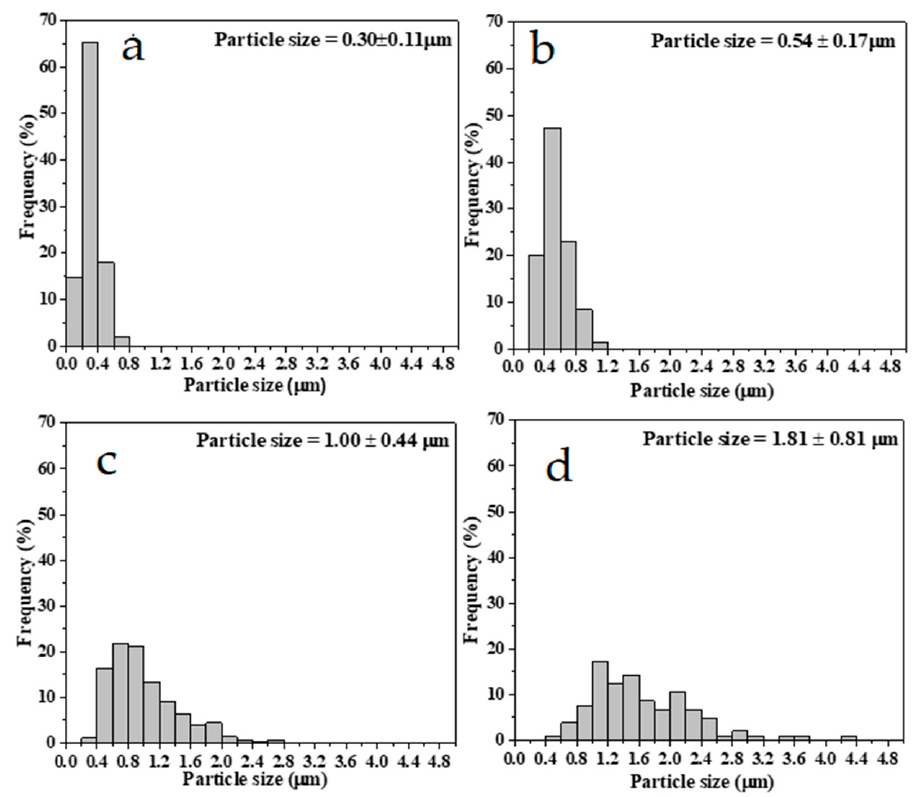
Figure 3. Particle size distributions of β -TCP powders calcined at temperatures of ( a ) 800, ( b ) 900, ( c ) 1000, and ( d ) 1100 °C.